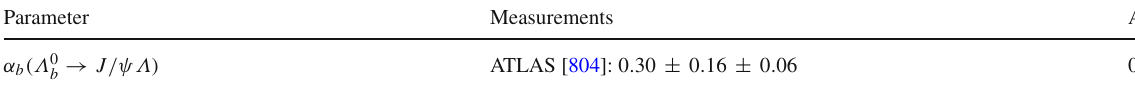
decays to charmonium b